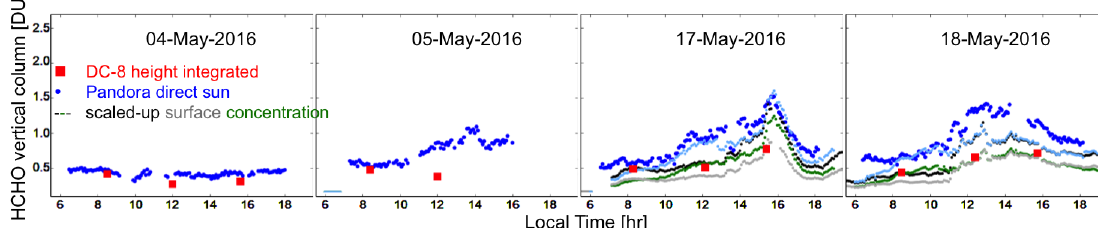
Figure 1. HCHO vertical columns during KORUS-AQ near Olympic Park, South Korea, derived from direct-sun Pandora measurements, DC-8 in situ measurements integrated from surface to 8km, and surface measurements scaled up to tropopause assuming various profile shapes (green: box with a median mixing layer height (MLH); grey: box with a measured MLH; light blue: box and exponential profile with a median MLH; and black: box and exponential profile with a measured MLH, modified from Spinei et al.,